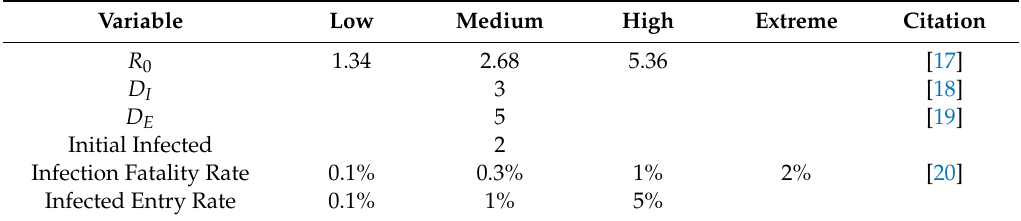
Table 1. Parameter values used in